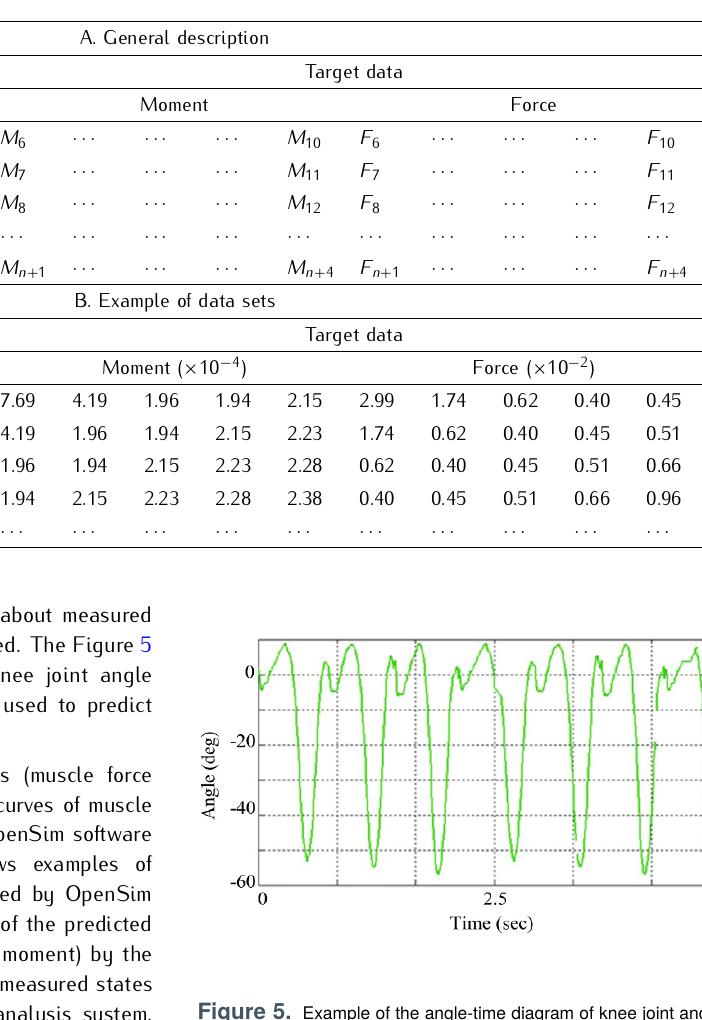
Figure 5. Example of the angle-time diagram of knee joint angle of a healthy